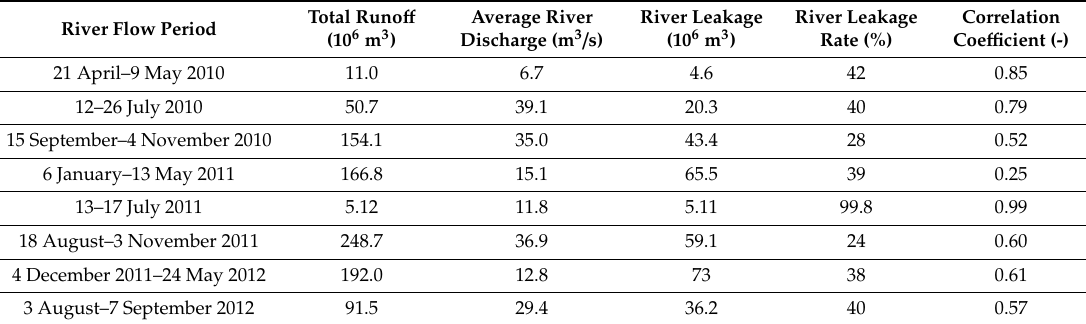
Table 4. Leakage rates of the river flow periods during the simulation period; correlation coe ffi cients indicate relationships between the stream runo ff and river